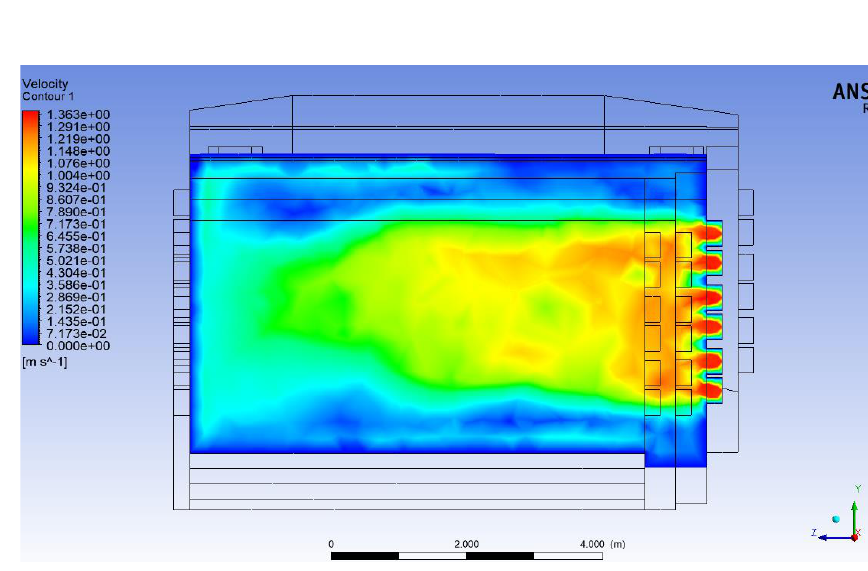
Figure 10. Base Design Velocity Contours